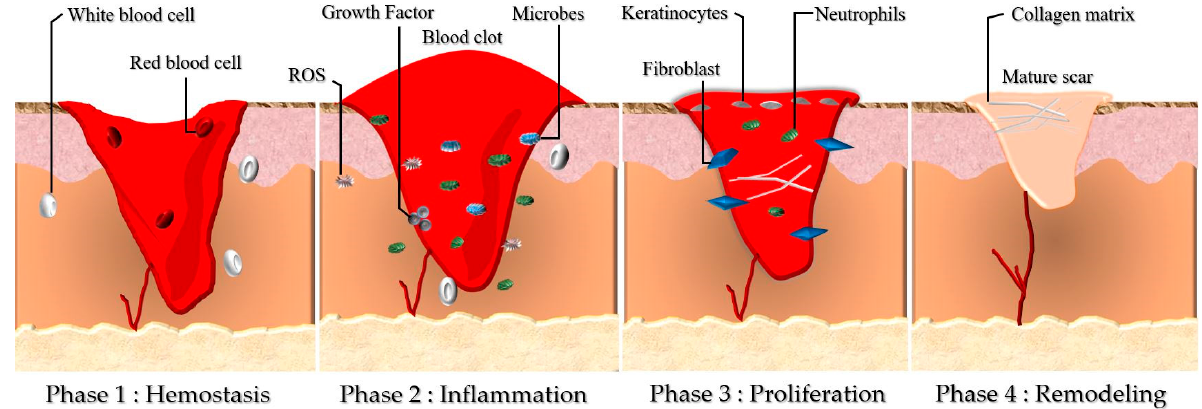
Figure 1. Cutaneous wound healing myriad includes four continuous phases, which involve Phase 1: Hemostasis, Phase 2: Inflammation, Phase: 3 Proliferation, and Phase 4: Remodelling. During these four phases, the blood platelets are activated before the injury, forming a blood clot, which plays a role in leukocyte recruitment. Then, as shown in Phase 2, neutrophils and macrophages remove debrides and fight against infection (bacteria, dead cells, pathogens). The angiogenesis process is initiated in Phase 3, where fibroblasts would migrate and proliferate. The collagen matrix is formed to restore the extracellular matrix in the remodelling phase (Phase 4), which turns into granulation tissue (mature